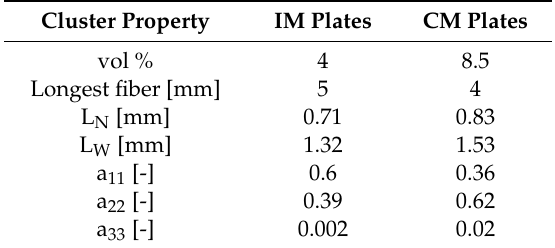
Table 2. Cluster properties for injection- and compression molded samples.